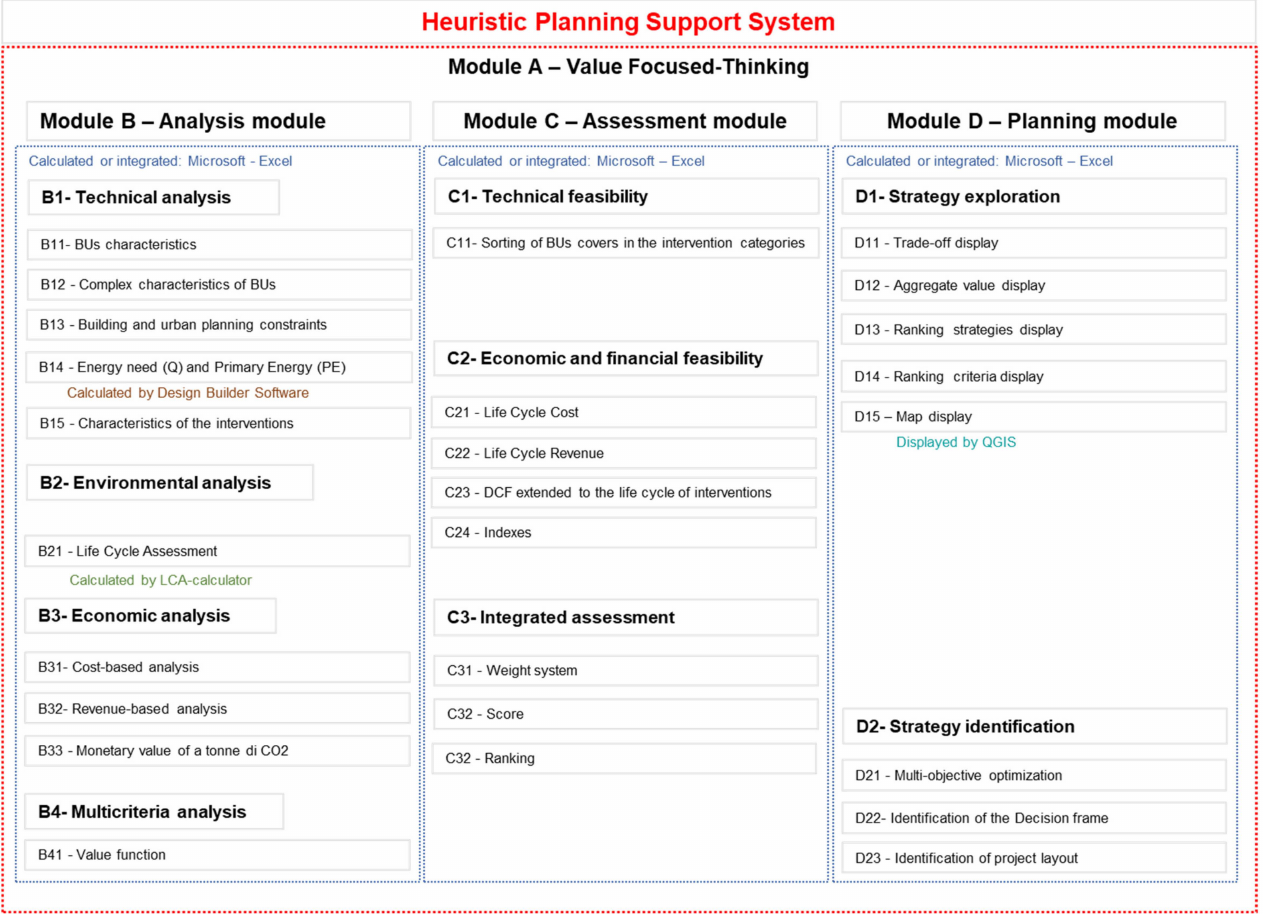
Figure 1. Heuristic Planning Support System (our